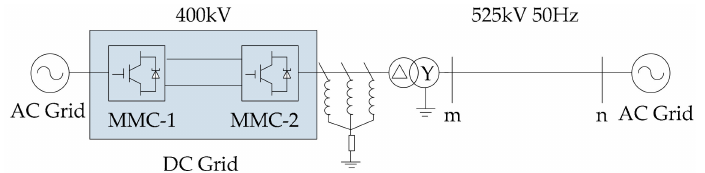
Figure 6. A typical AC/DC hybrid system simulation model. Table 1. Simulation parameters of the test